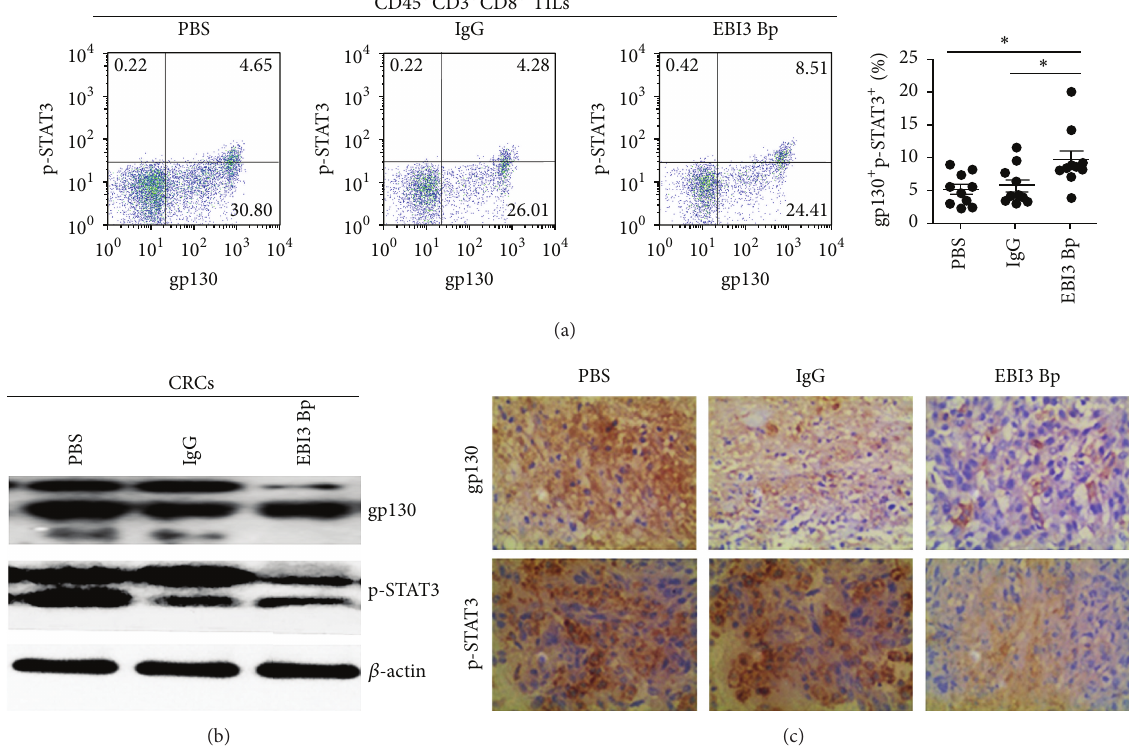
Figure 5: EBI3 regulates the tumor growth and antitumor cytotoxic T lymphocyte response by bidirectional reciprocal-regulation STAT3 signaling pathway. (a) Representative images for the gp130 and p-STAT3 expression on CD45 + CD3 + CD8 + TILs after being cocultured with CRC cells stimulated with EBI3 Bp for 6h, an isotype IgG, and PBS for control. Scatter plot graph showing the percentage of gp130 + p-STAT3 + T cells on CD45 + CD3 + CD8 + TILs. (b) The expression level of gp130 and p-STAT3 was detected by Western blot analysis. (c) gp130 and p- STAT3 in tumor of xenograft models were detected by immunohistochemistry. Low expression of gp130 and p-STAT3 was observed in mice treated with EBI3 Bp as compared to those of control mice. ∗ 𝑃 < 0.05